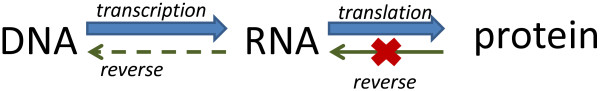
The Central Dogma of Molecular Biology.